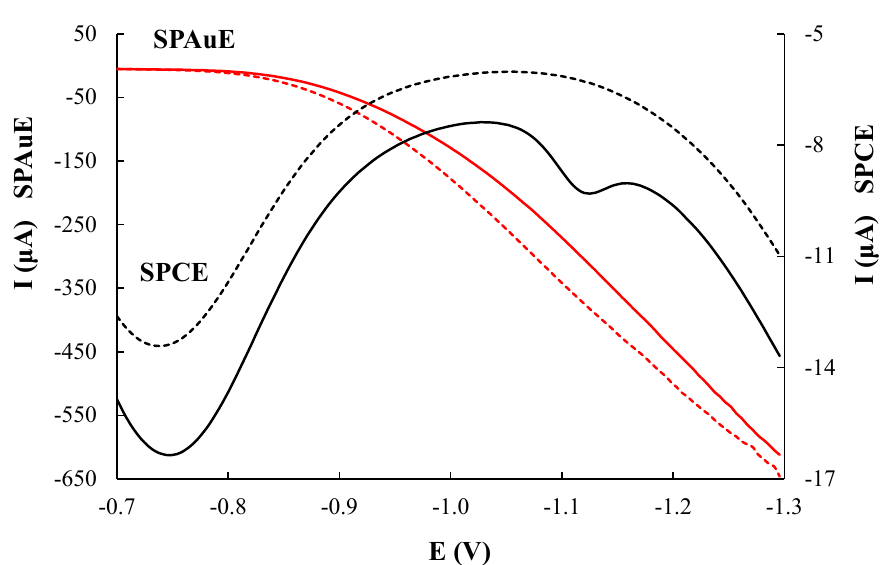
Figure 1. Differential pulse adsorptive stripping voltammograms of 10 µg L − 1 Ni(II) recorded on carbon screen-printed electrode, SPCE, (black lines) and gold screen-printed electrode, SPAuE, (red lines) in 0.1 mol L − 1 ammonia/ammonium buffer solution (pH 9.2) and 5 × 10 − 5 mol L − 1 DMG applying a E d of − 0.7 V and a t d of 120 s. Blank signals in dashed lines. Table 1. Calibration data for the Ni(II) determination on SPCE at ammonium/ammonia buffer pH 9.2 applying an E d of − 0.7 V and a t d of 120 s. Standard deviations are denoted by